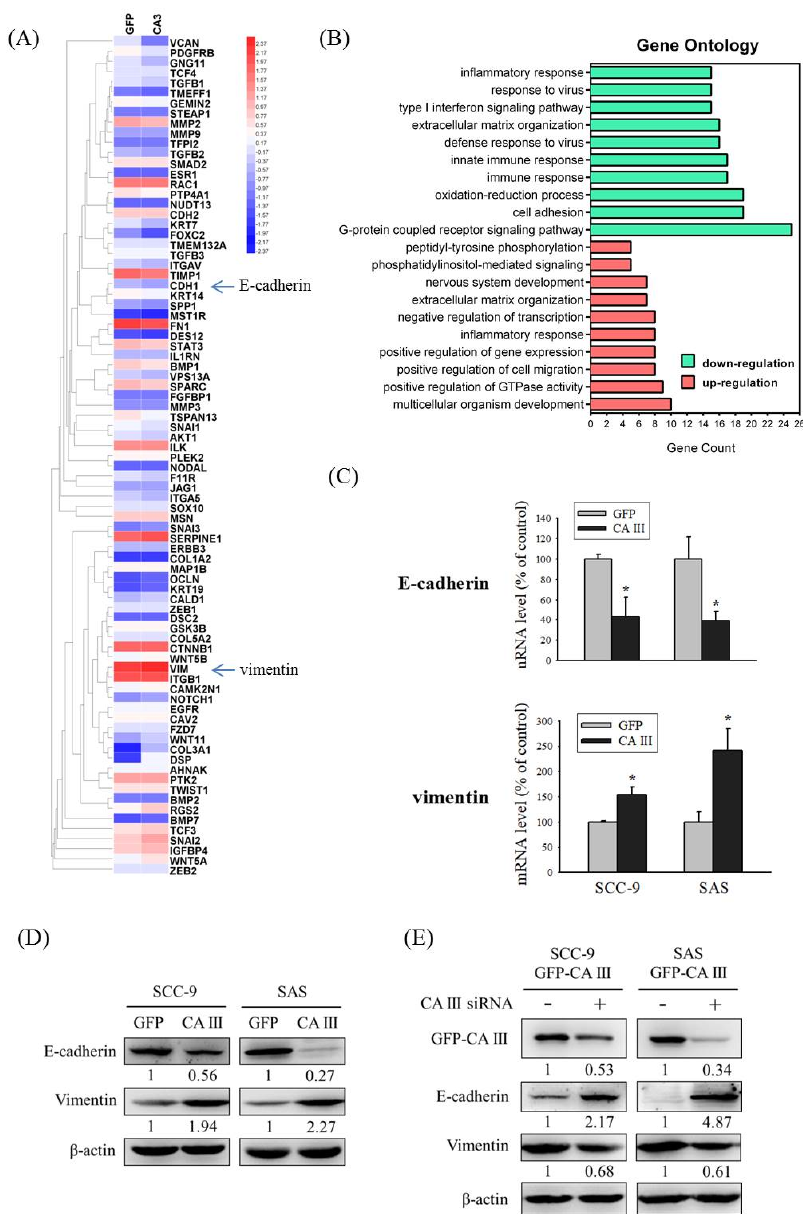
Figure2. CAIIIregulatesepithelial–mesenchymaltransition(EMT)markersinoralcancercells. ( A )Heat Figure 2. CA III regulates epithelial–mesenchymal transition (EMT) markers in oral cancer cells. ( A ) map including 84 EMT-related genes in SCC-9 GFP and SCC-9 CA III cells was assessed by Human Heat map including 84 EMT ‐ related genes in SCC ‐ 9 GFP and SCC ‐ 9 CA III cells was assessed by OneArray ® . Blue arrows indicate the downregulation of E-cadherin (CDH1) and upregulation of Human OneArray ® . Blue arrows indicate the downregulation of E ‐ cadherin (CDH1) and vimentin (VIM) in SCC9 CA III cells. ( B ) Gene Ontology analysis for up-regulation and down-regulation upregulation of vimentin (VIM) in SCC9 CA III cells. ( B ) Gene Ontology analysis for up ‐ regulation genes between SCC-9 GFP and SCC-9 CA III cells was analyzed by a functional annotation tool (DAVID and down ‐ regulation genes between SCC ‐ 9 GFP and SCC ‐ 9 CA III cells was analyzed by a functional Bioinformatics Resources 6.8). ( C ) The mRNA levels of EMT markers E-cadherin and vimentin were annotation tool (DAVID Bioinformatics Resources 6.8). ( C ) The mRNA levels of EMT markers E ‐ analyzed by real-time PCR. The relative mRNA expression was normalized to GAPDH. * p < 0.05 cadherin and vimentin were analyzed by real ‐ time PCR. The relative mRNA expression was compared with the GFP. ( D ) The protein expressions of EMT markers E-cadherin and vimentin were normalized to GAPDH. * p < 0.05 compared with the GFP. ( D ) The protein expressions of EMT markers analyzed by Western blot in GFP and CA III stable cells. β -actin was used as the loading control. E ‐ cadherin and vimentin were analyzed by Western blot in GFP and CA III stable cells. β‐ actin was ( E ) The protein expression of EMT markers E-cadherin and vimentin after transfection with scrambled used as the loading control. ( E ) The protein expression of EMT markers E ‐ cadherin and vimentin after siRNA or CA III siRNA in CA III stable cells. β -actin was used as the loading transfection with scrambled siRNA or CA III siRNA in CA III stable cells. β‐ actin was used as the loading control.